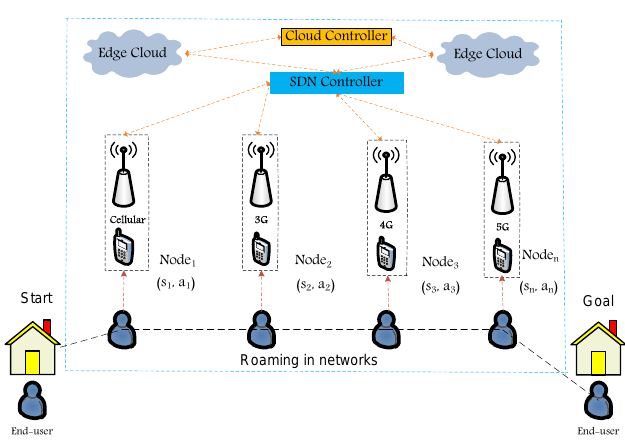
Figure 3. Mobility Model Waypoint States